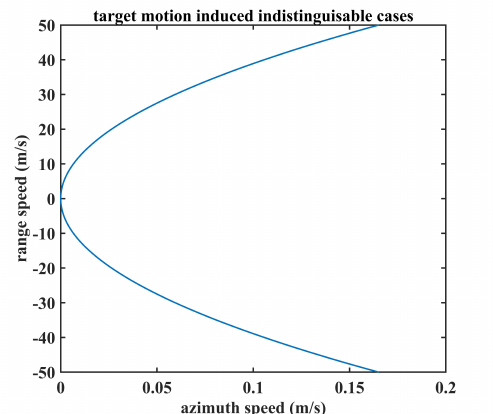
Figure 3. The azimuth and range speed which can induce indistinguishable cases using parameter of Gaofen-3.